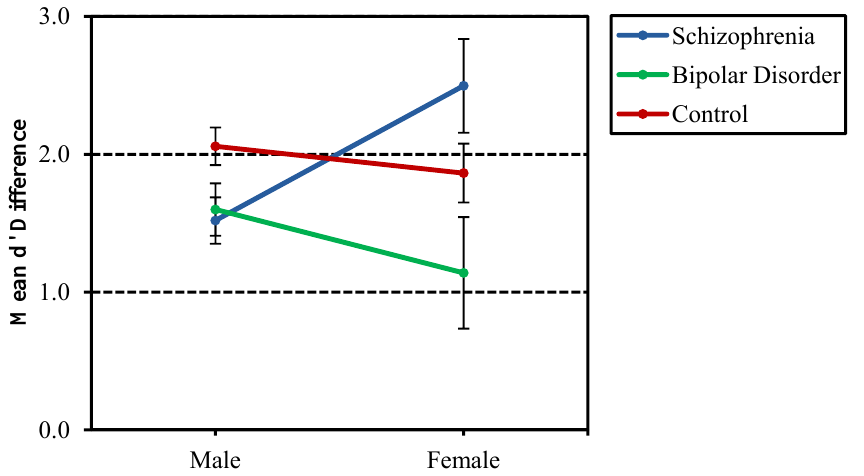
Figure 5. Mean d' difference scores (nonsense d' subtracted from geometric d') separated by group (probands with schizophrenia, probands with bipolar disorder and nonpsychiatric controls) and gender. Females with schizophrenia appeared to benefit more greatly from nameable geometric structure in figures as compared to males with schizophrenia, but this difference should be interpreted with caution, since there were only seven females in each of the schizophrenia and bipolar disorder probands